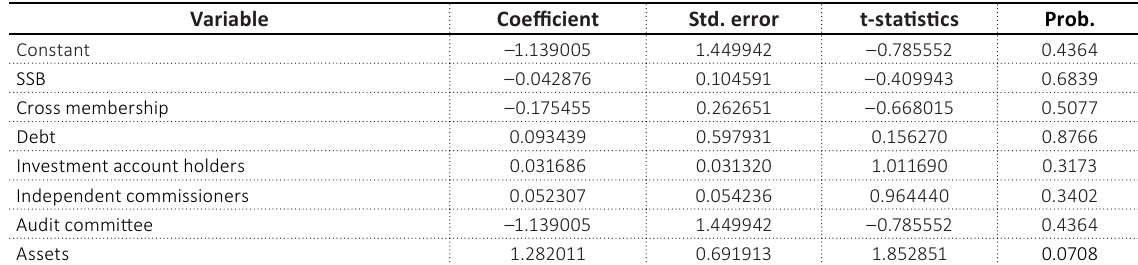
Table 3. Test results of the fixed effect model